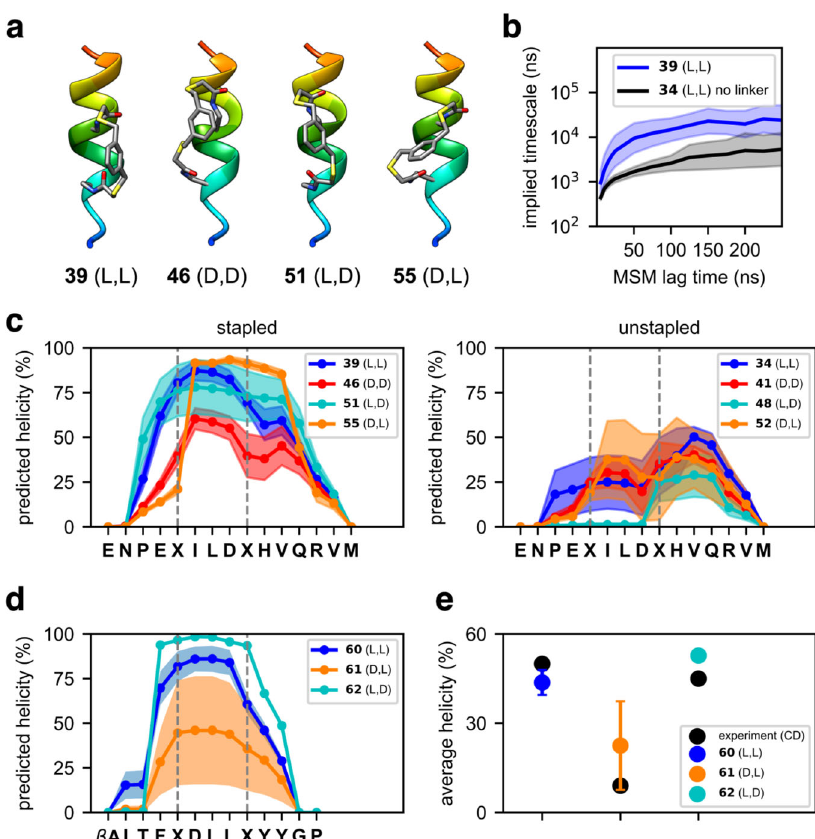
Fig. 6 Molecular dynamics simulation. a Energy-minimized structures of 1,3-benzenedimethanethiol crosslinked Axin peptides 39 , 46 , 51 and 55 . b The slowest implied timescale of peptides 39 and 34 (no linker) shown as a function of MSM lag time. c Predicted per-residue helicity pro fi les of stapled and unstapled Axin peptides. d Predicted per-residue helicity pro fi les of HIV C-CA binding peptides 60 – 62 . e Comparison of experimental (CD) and predicted average helicities of peptides 60 – 62 . Data in panels b – e are presented as mean values (dark lines)± SEM (shaded regions) estimated from a bootstrap procedure where fi ve MSMs ( n = 5) were constructed by sampling the input trajectory data with replacement.